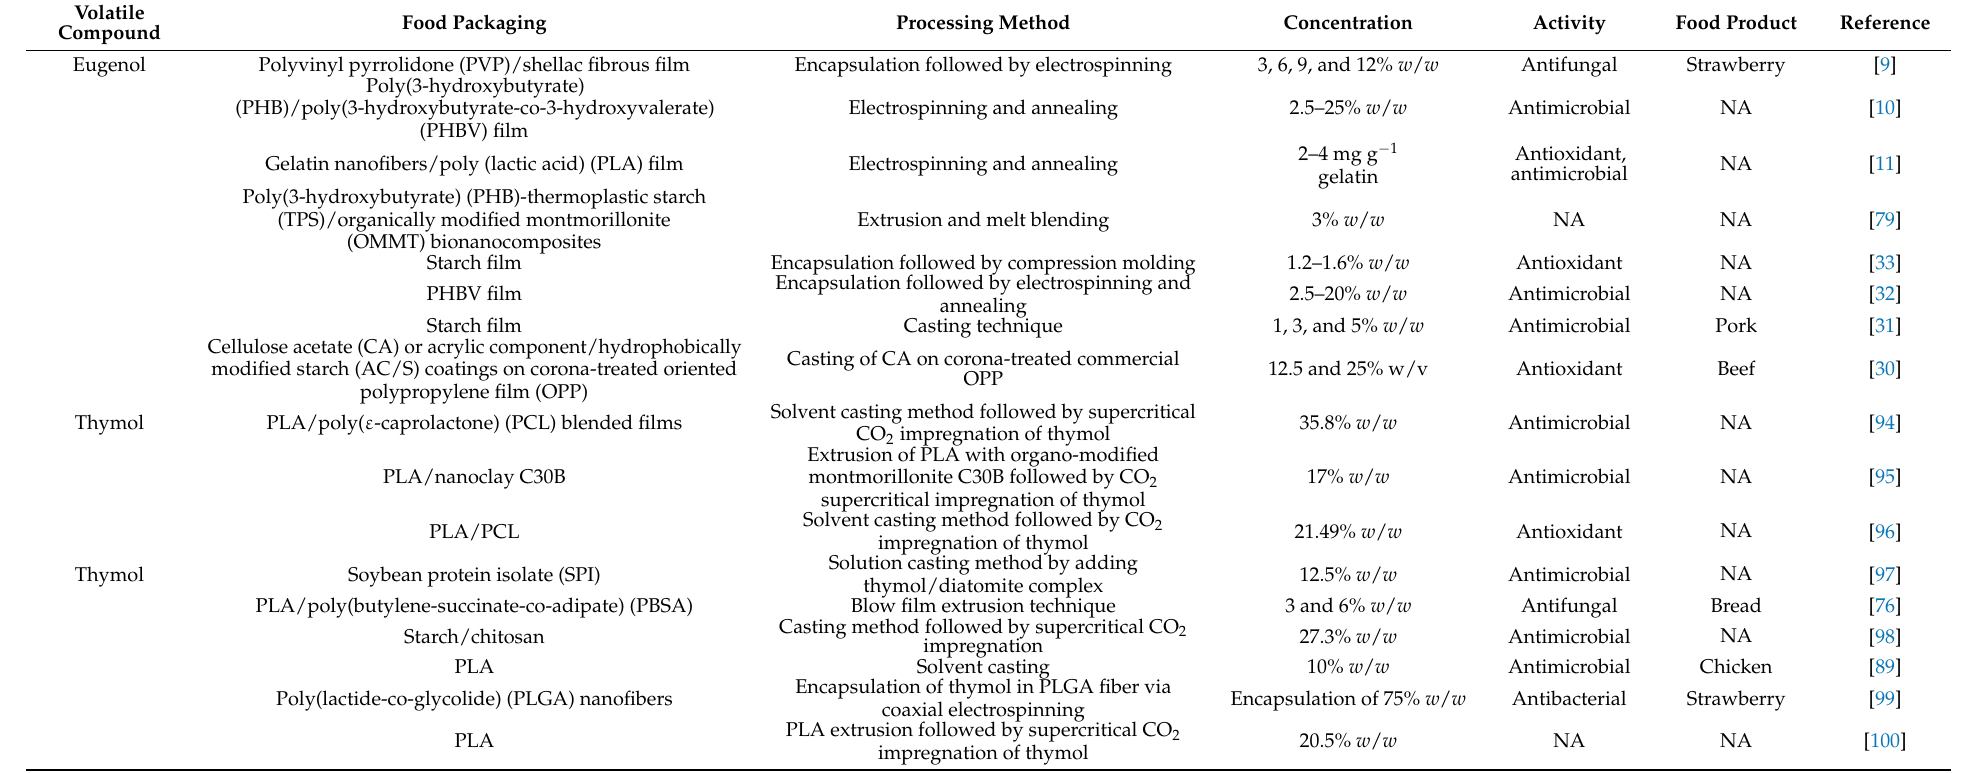
Table 2. Current applications of major volatile compounds used in food packaging. NA: not